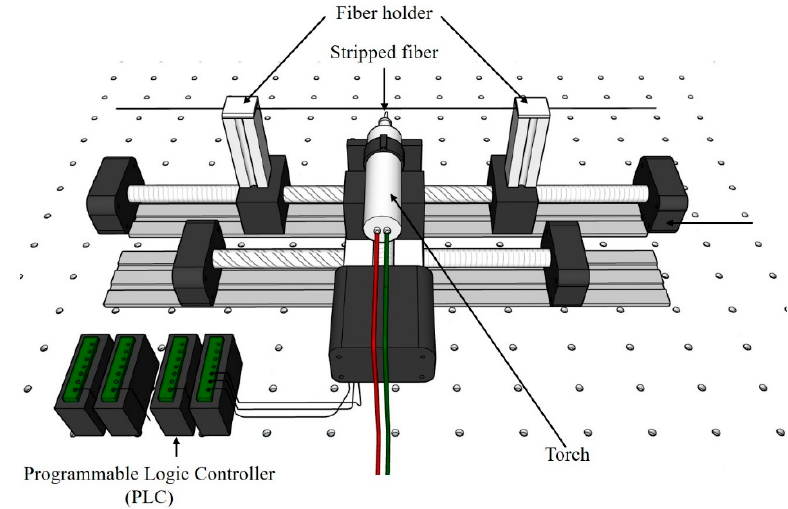
Figure 1. Schematic of the MF taper fabrication setup.